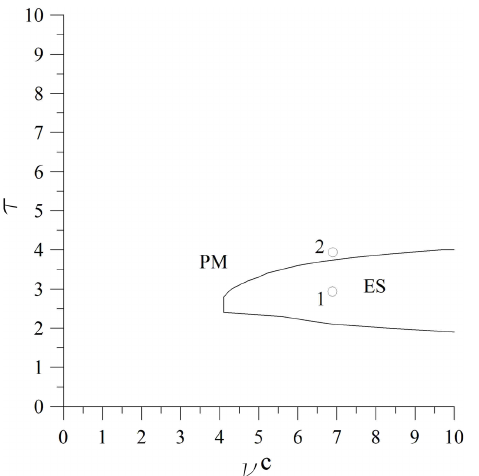
Fig. 2. Parameter domains ( τ,ν c ) admitting equilibrium state (ES) or periodic motion (PM) are illustrated for the single-block model at c = 3. Time series and phase portraits corresponding to points 1 and 2 are shown in Fig. 3. The initial function for U is selected such that its values within the interval [ − τ, 0] are set by Eq. (6) with c = 0.